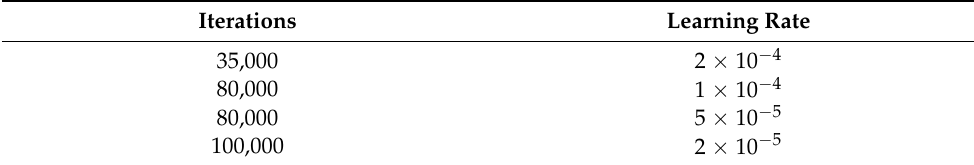
Table 3. Learning rate values used in network training.